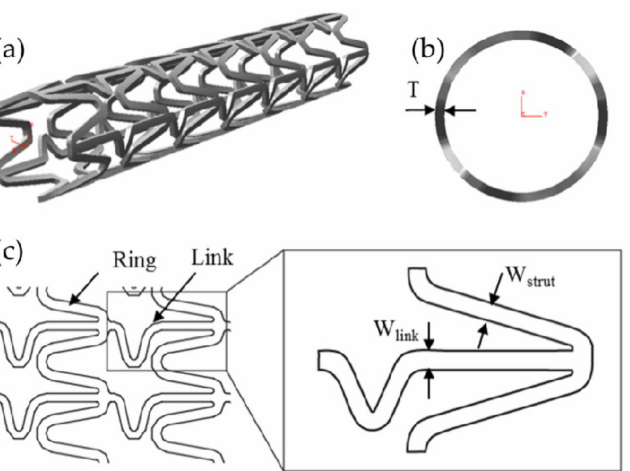
Figure 12. MAC-Plus stent and parameters [105]: ( a ) Oblique view of MAC-Plus; ( b ) View along z-axis (axial direction) is used to show the stent thickness; ( c ) Planar view of the MAC-Plus stent